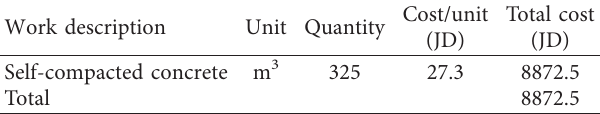
Figure 22: Internal walls of Ras Alain Multipurpose Hall by CC. Table 3: Cost of construction works above ground level by CC.